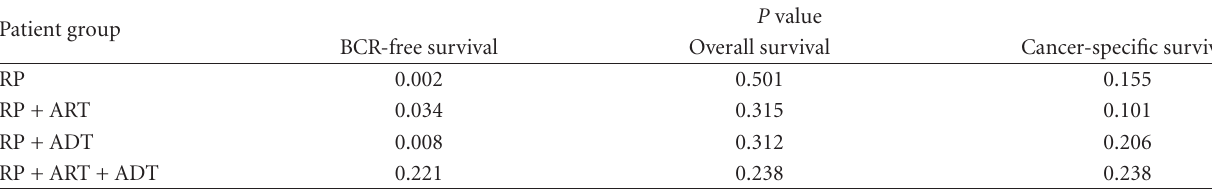
Table 6: Kaplan-Meier survival analysis, log-rank test: comparison between patients with initial PSA ≤ 20 ng/mL versus patients with PSA ≤ 20ng/mL in four patient groups (patients treated by RP only versus RP plus ART versus RP plus ADT versus RP plus ART plus ADT) with regard to BCR-free, OS, and CSS